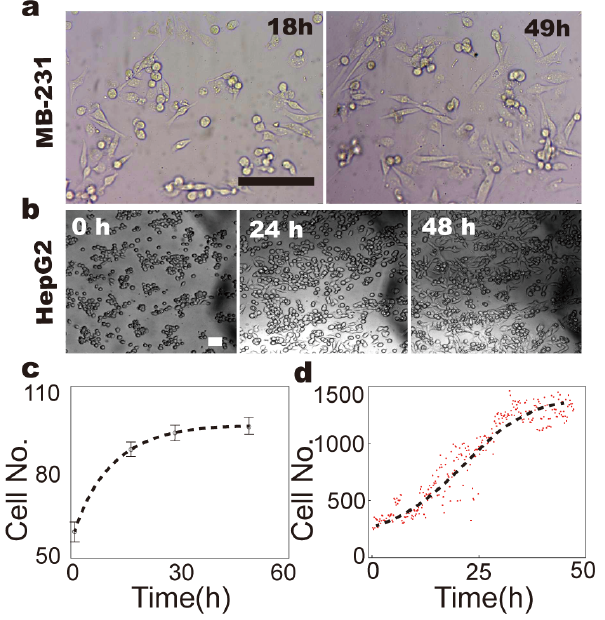
Figure 4. Culture of tumor-origin cells. ( a , b ). Live-cell images of MB-231 ( a ) and HepG2 cells ( b ) during 48 h culture on chip. ( c , d ). Growth rate of MB-231 ( c ) and HepG2 cells ( d ). Dots are experimental data, and the dashed line is the fitting curve. Scale bars denote 100 μ m.